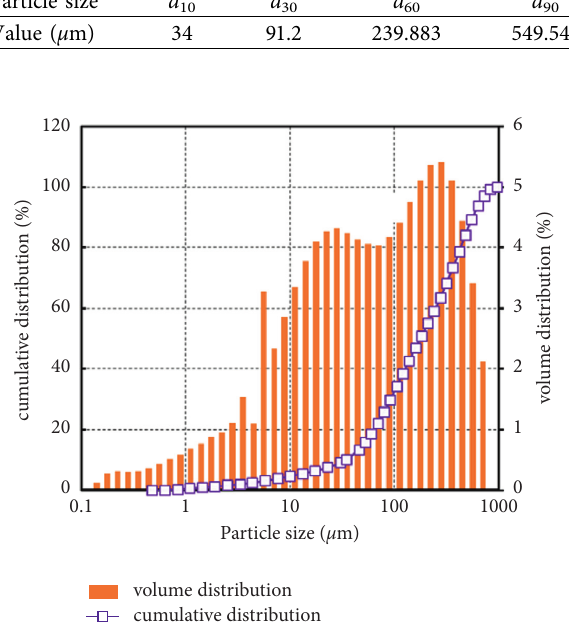
Figure 4: Particle size distribution of the whole